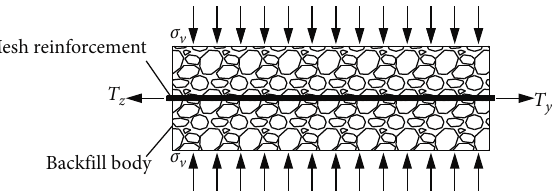
Figure 7: Stress model of flexible grid reinforcement.